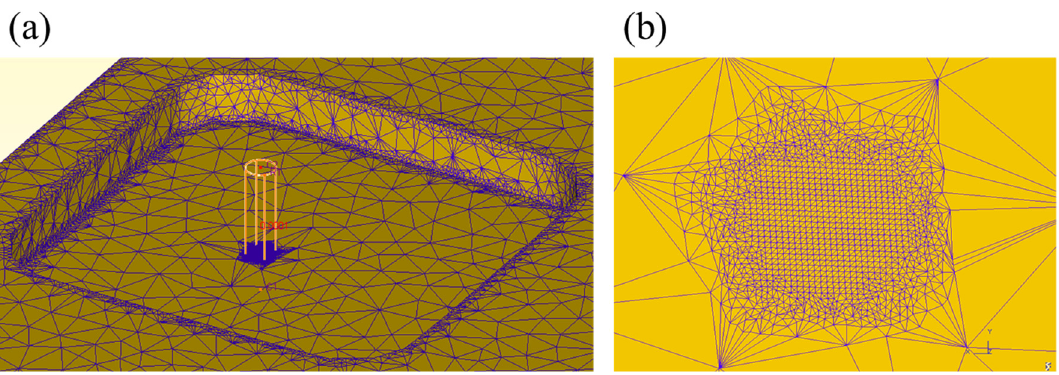
Figure 2. Schematic diagram of workpiece with fine mesh elements ( a ) mesh refinement ( b ) partially enlarged mesh.